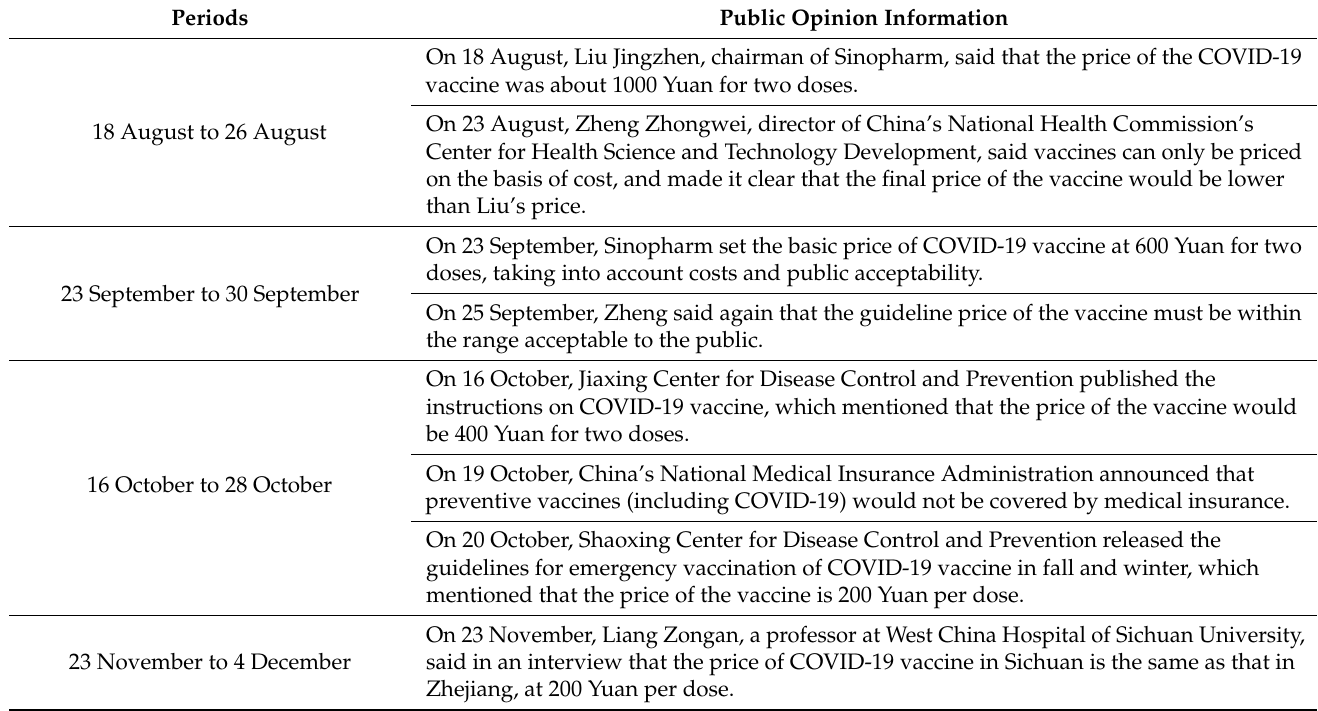
Table 4. Public opinion information in each period.